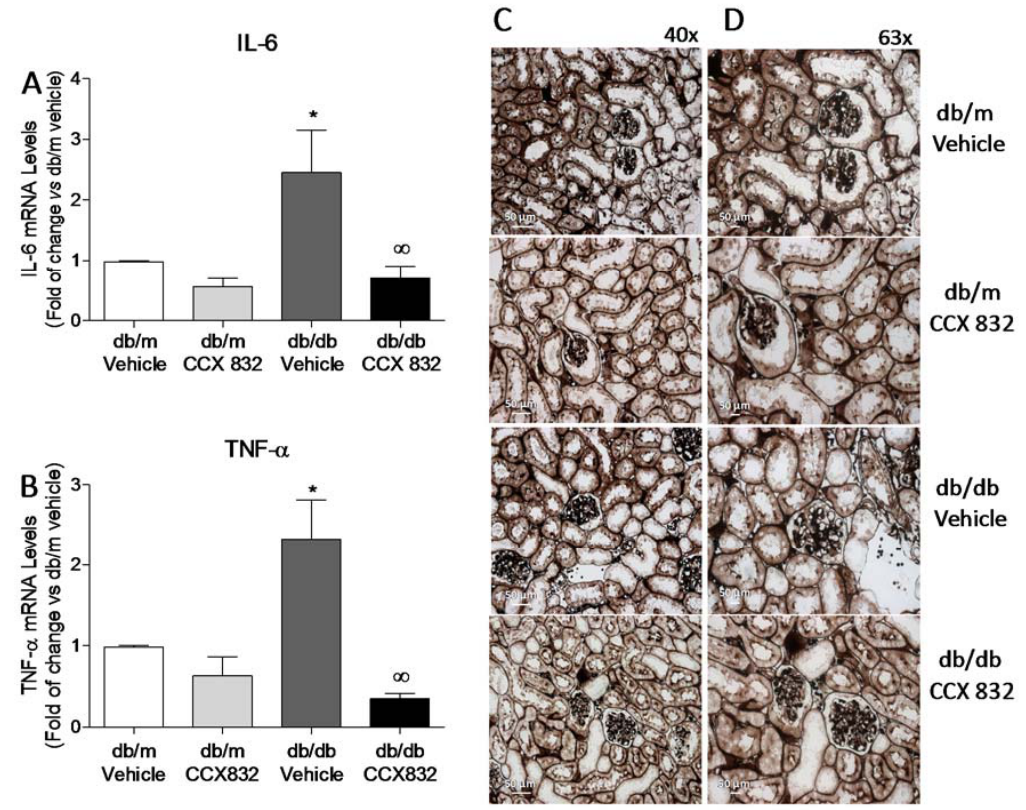
Figure 5. ChemR23 antagonism reduces the expression of renal inflammatory markers but does not change kidney structure in db/db mice. ( A , B ) mRNA expression, determined by real time-polymerase chain reaction (PCR), of IL-6 and TNF- α , respectively. The values were normalized by GAPDH mRNA expression. ( C , D ) Representative images of renal tubule and glomerulus stained with Grocott-Gomori’s methenamine-silver nitrate from vehicle and CCX832-treated db/m and db/db mice. Scale bar: 50 µm. Magnification of 40X ( C ) and 63X ( D ). Results represent the mean ± SEM of 4–5 experiments. * p < 0.05 vs. db/m, ∞ p < 0.05 vs. db/db vehicle .